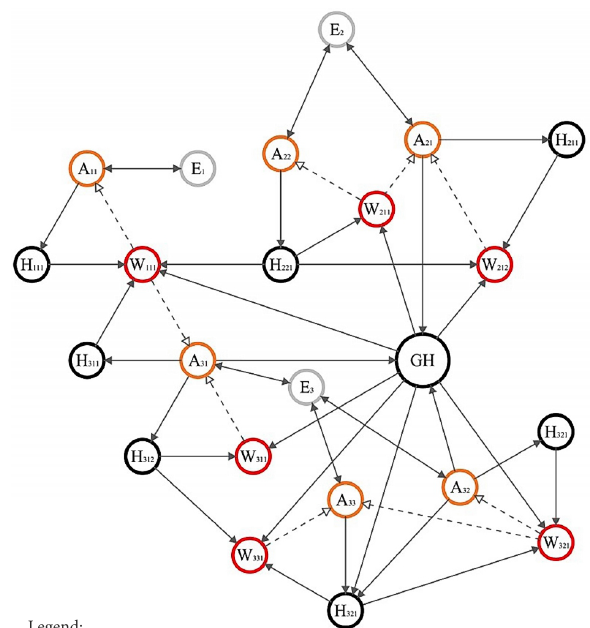
– Grey circles with the letter E: building model elements; – Orange circles with the letter A: construction activities needed to construct the building model element; – Black circles with the letter H: hazards which are caused by the activities; – Black circle with the letters GH: global hazards caused by the